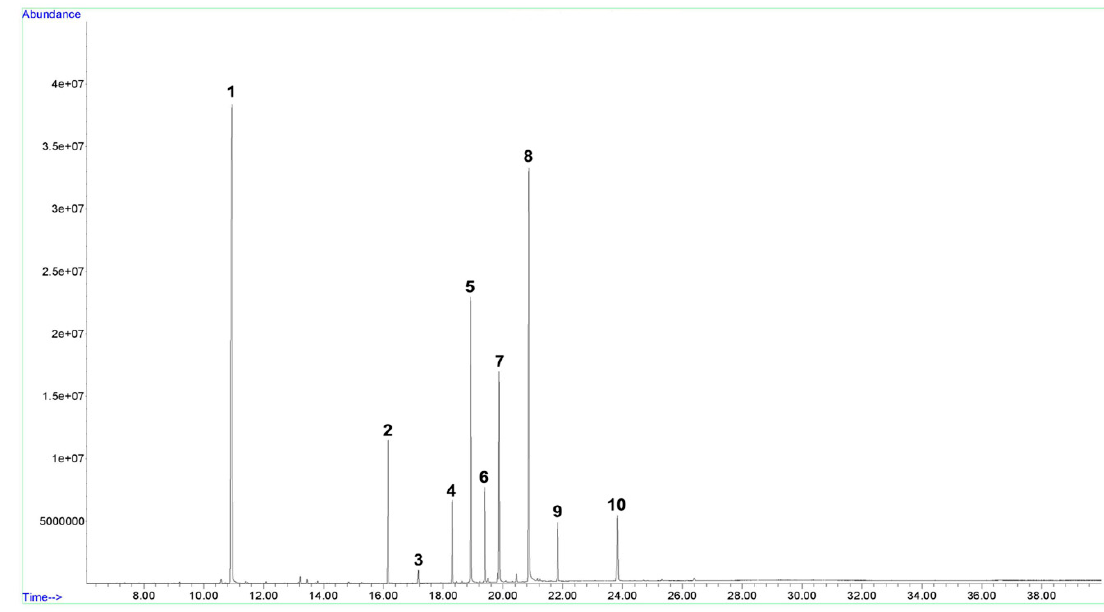
Figure 1. Total ion chromatogram of rose hydrosol. 1 : 1,8-cineole (internal standard), 2 : linalool, 3 : 4-terpineol, 4 : alpha terpineol, 5 : citronellol, 6 : nerol, 7 : geraniol, 8 : 2-phenlyethanol, 9 : methyl eugenol, 10 :